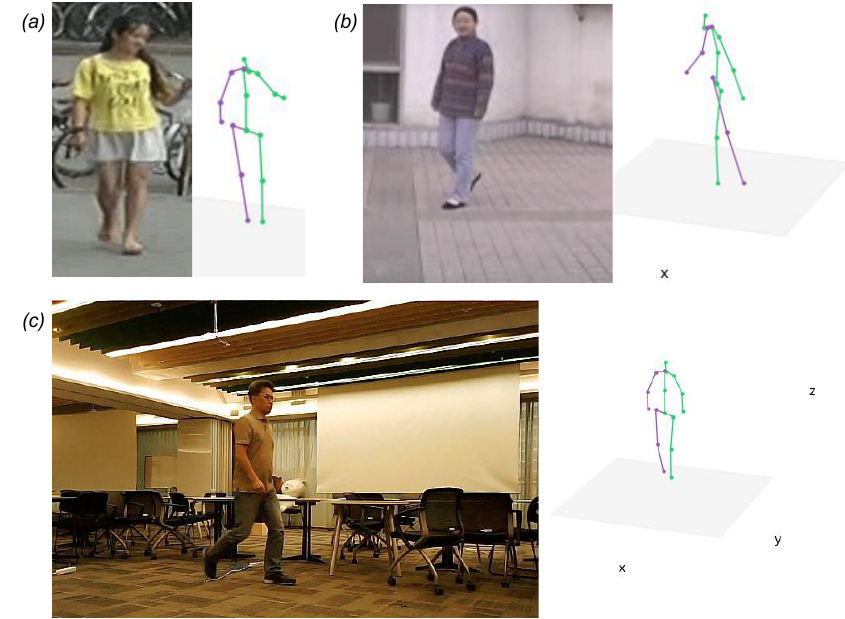
Figure 15. Examples of the 3D estimation. ( a ) MARS datasets. ( b ) CASIA-A datasets. ( c ) A sample from the